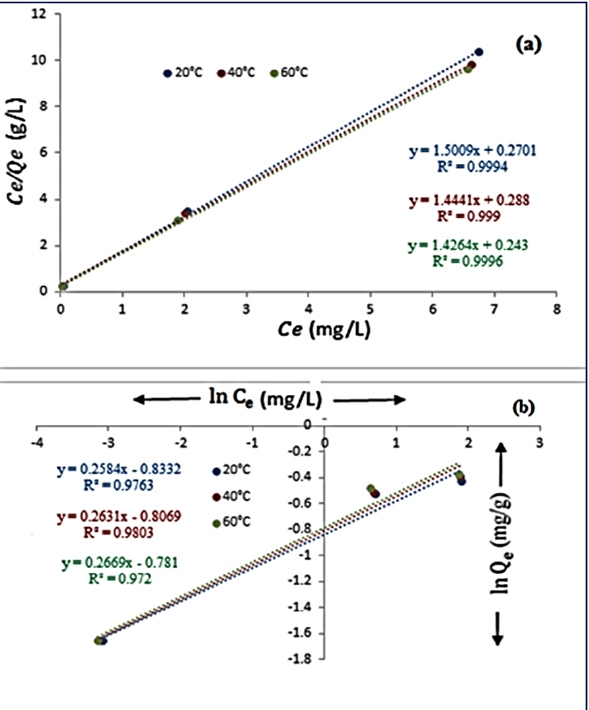
Figure 11. The Langmuir ( a ) and Freundlich ( b ) isotherm plot for the adsorption of lead ions by